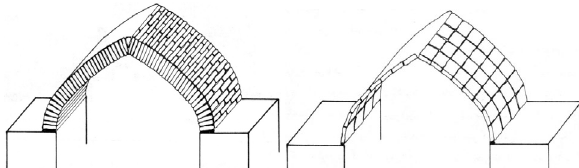
Figure 11. From left; Herreh brickwork vault and Chapileh brickwork vault, (Pirnia, 1995).